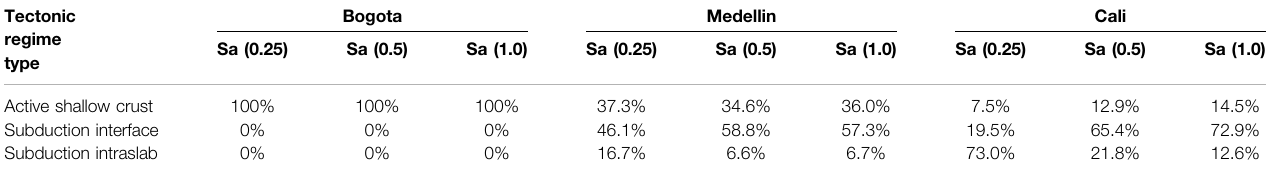
TABLE 2 | Percentages of the number of events selected for each city, structural period, and tectonic regime type. Tectonic regime